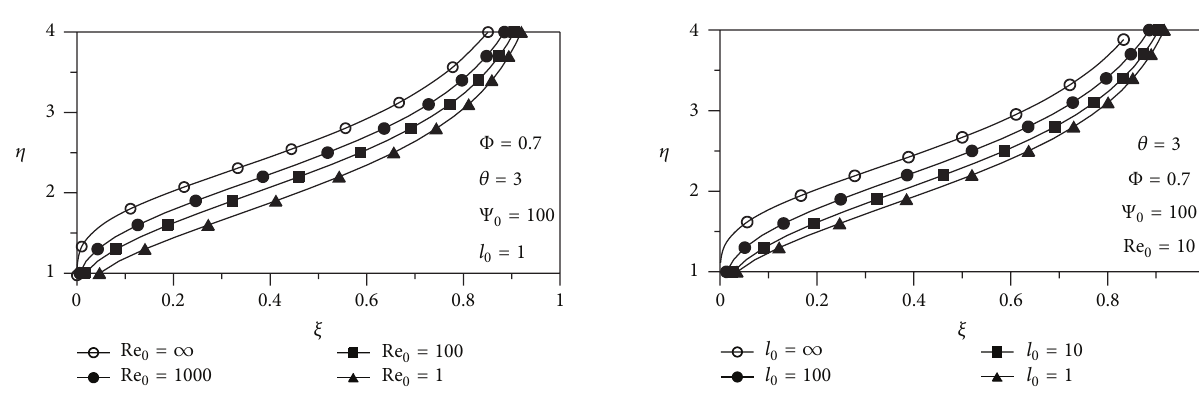
Figure 8: Effect of Re on optimum profile of metal content.